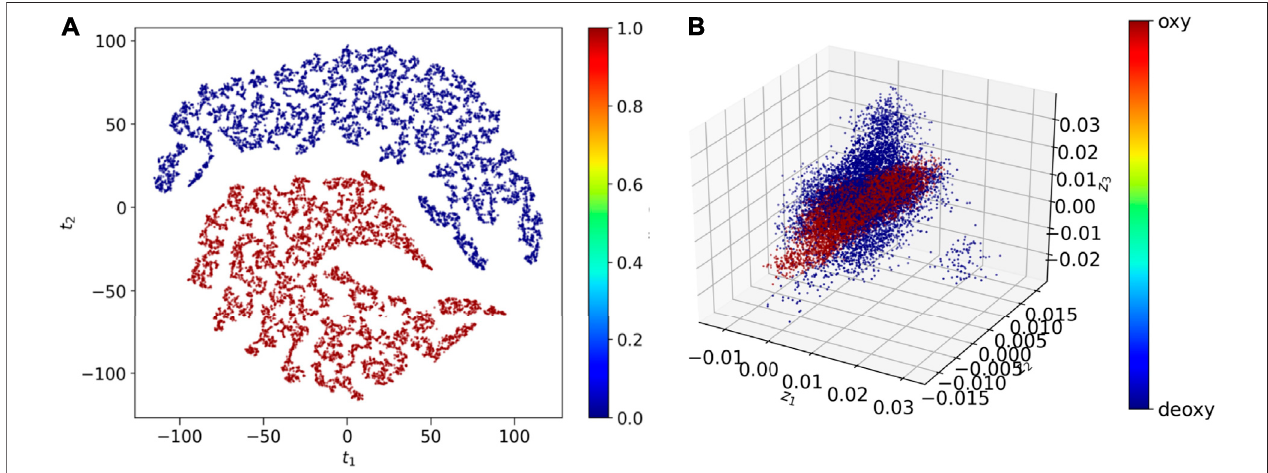
FIGURE10| CVAE-baseddeeplearninganalysis.ThereduceddimensionallatentspaceofCVAE-learntfeaturesofthehighdimensionaloriginalinputareshownin (A) 2D representation and (B) 3D representation following t-sne treatment on the compressed data. The results show that the two systems [i.e., Oxy-HCN (red) and Deoxy-HCN (red)] are different based on their local and global conformational